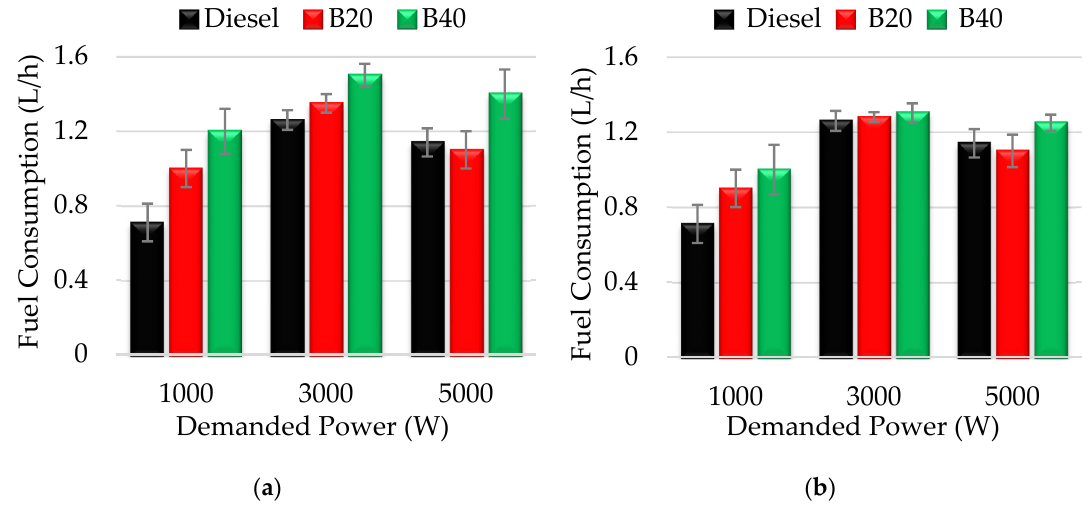
Figure 4. Fuel consumption values (L/h) at different demanded power values (1, 3, 5 kW) for: ( a ) diesel/acetone/sunflower oil; ( b ) diesel/acetone/castor oil blends. The measure errors are represented as standard deviation using error bars.